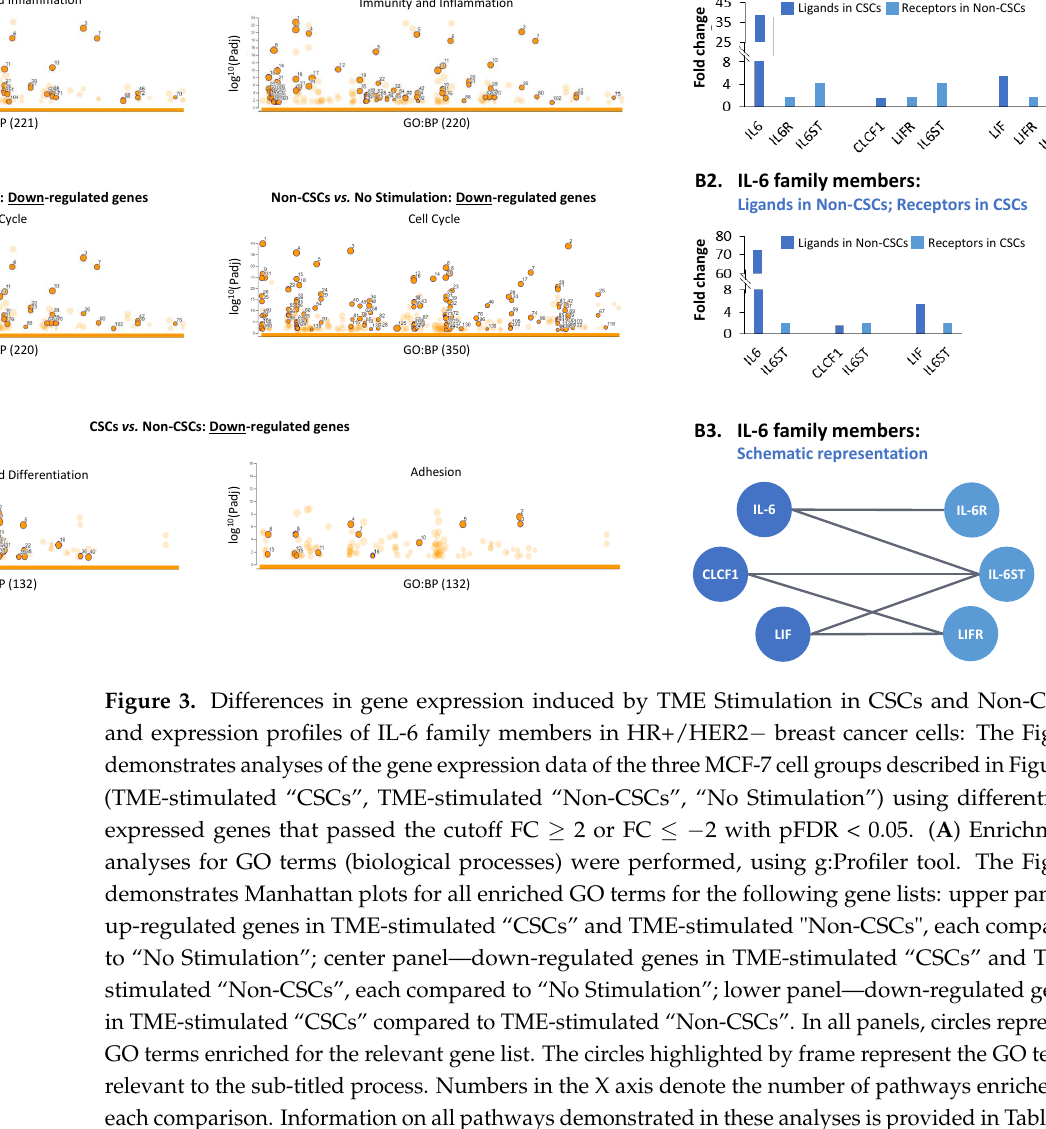
CSCs vs. No Stimulation: Up-regulated genes Non-CSCs vs. No Stimulation: Up-regulated genes Immunity and Inflammation Immunity and Inflammation CSCs vs. No Stimulation -Up regulated genes